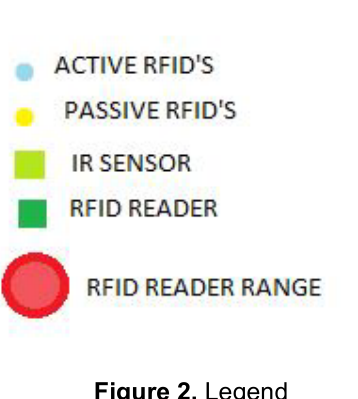
Figure 2. Legend